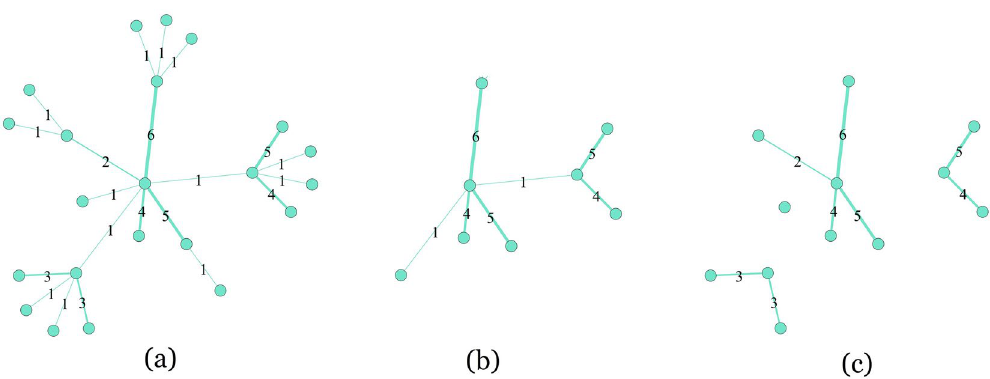
Figure 4. A comparison of the h -backbone and the Serrano backbone, ( a ) The original network, where the number of an edge represents its weight ( b ) The h -backbone. ( c ) A possible result of the Serrano backbone 10 .